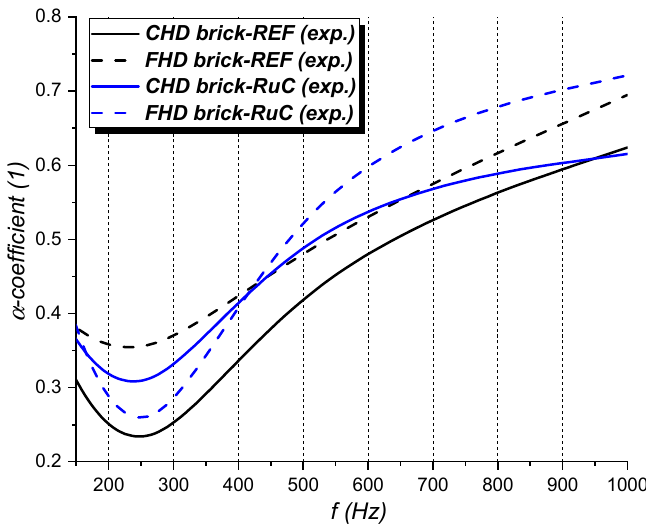
Figure 18. Experimental sound–absorption curves ( α vs. f ).